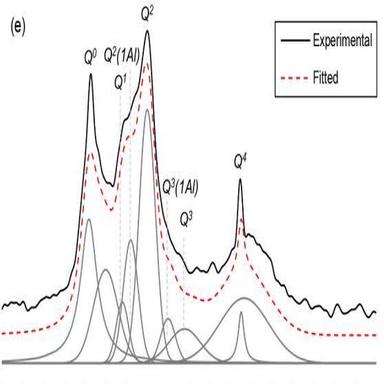
Relative Si fraction (%) of the samples as calculated from the deconvolution of 29Si NMR spectra.